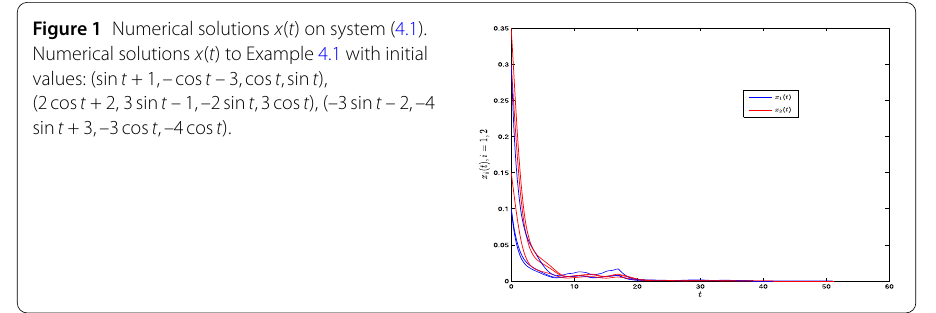
Figure 1 Numerical solutions x ( t ) on system (4.1). Numerical solutions x ( t ) to Example 4.1 with initial values: (sin t + 1,–cos t – 3,cos t ,sin t ), (2cos t + 2, 3sin t – 1,–2sin t ,3cos t ), (–3sin t – 2,–4 sin t + 3,–3cos t ,–4cos t